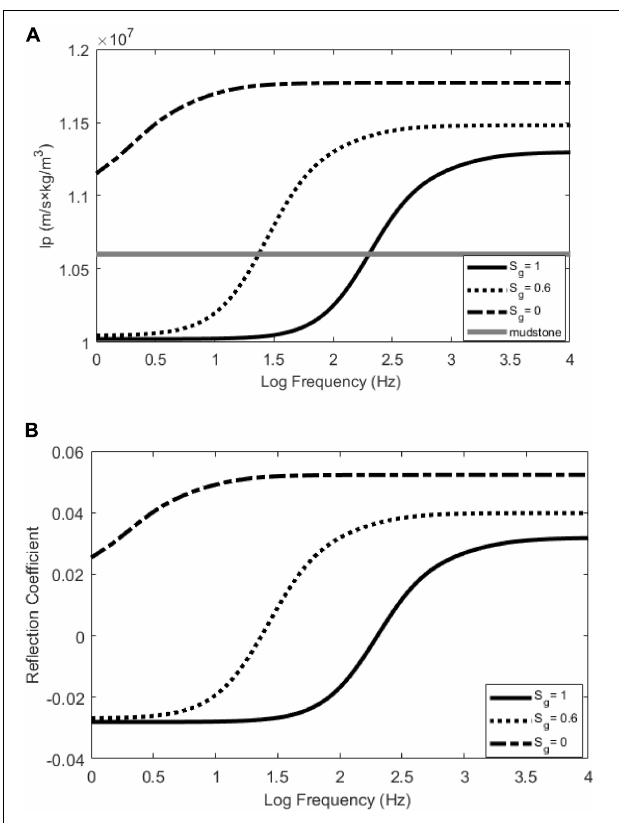
FIGURE 3 | (A) Frequency-dependent P-wave impedance Ip; and (B) frequency-dependent reflection coefficient of the normal incidence at the interface between the mudstone and the tight gas sandstone.